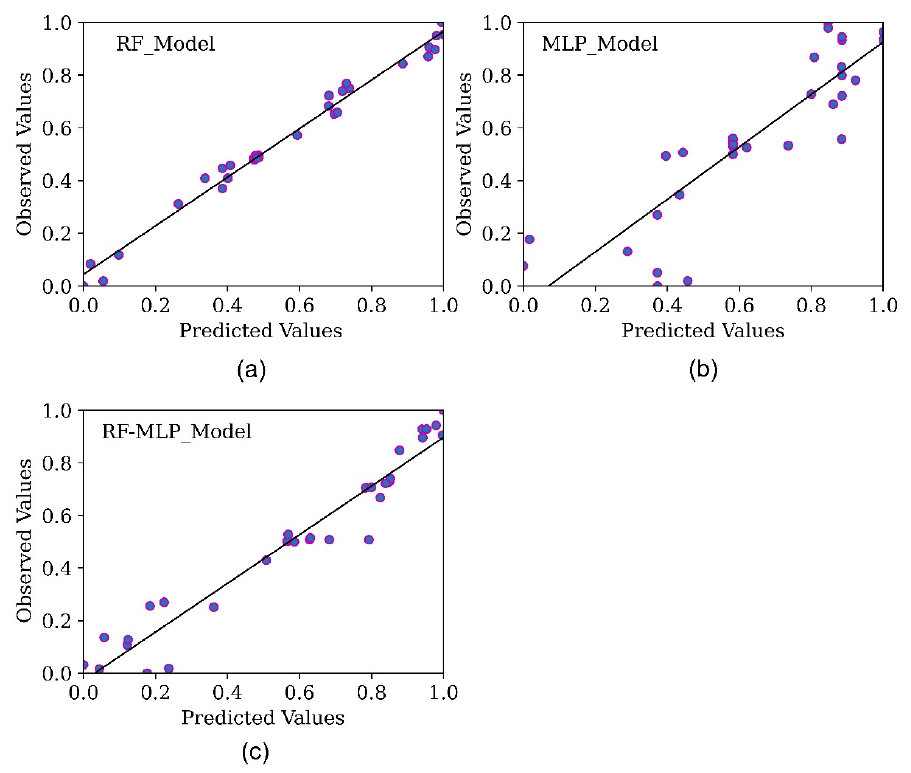
Figure 6. ( a – c ). Depiction of the residuals of RF, MLP, and RF-MLP models, respectively. A comparison of predicted and observed values of performance accuracy on test data based on the model’s RF, RF–MLP, and MLP, respectively, is shown in Figure 7, below.